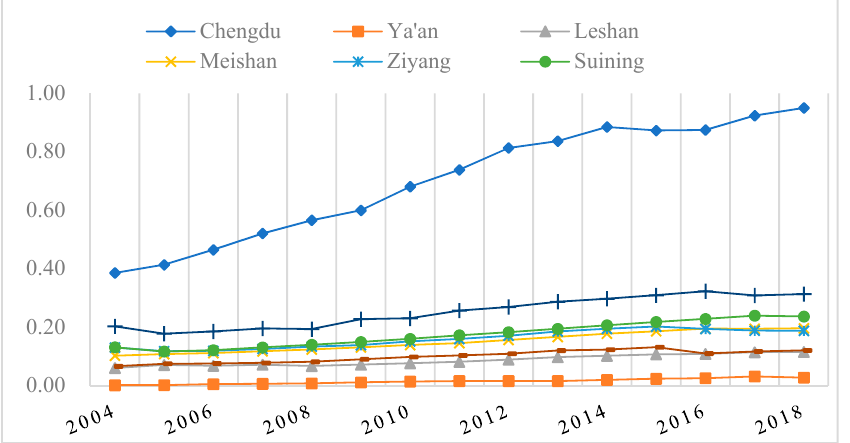
Figure 4. Intensive urban land use level from 2004 to 2018.